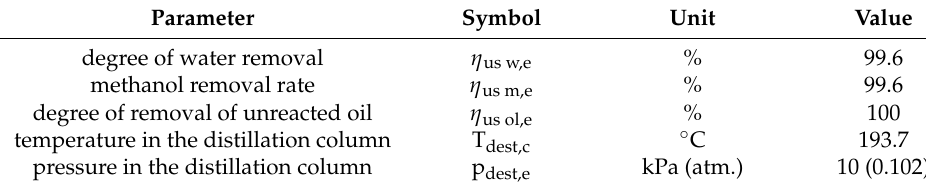
Table 5. Technological assumptions for the purification of methyl